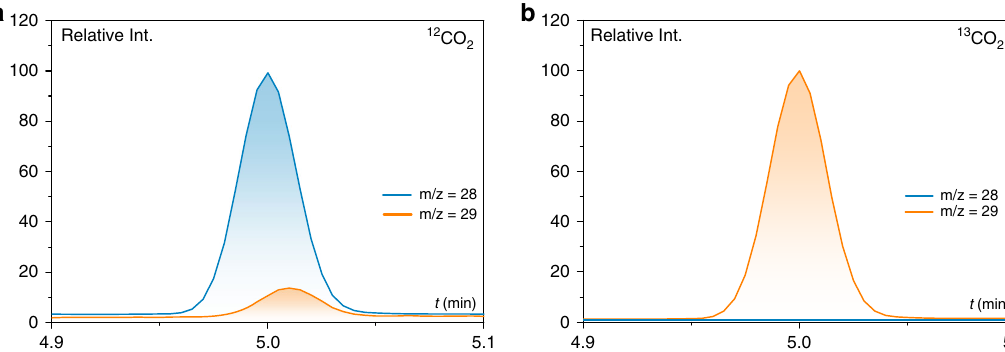
Fig. 6 GC/MS chromatograms at the retention time of carbon monoxide. Speci fi c traces of m / z = 28 value (blue) and m / z = 29 value (orange) after 2 h of electrolysis at illuminated Co-qPyH | f-TiO 2 | CIGS ( E bias = − 0.06 V vs. RHE), in 0.1 M KHCO 3 electrolyte saturated with 12 CO 2 ( a ) and 13 CO 2 ( b